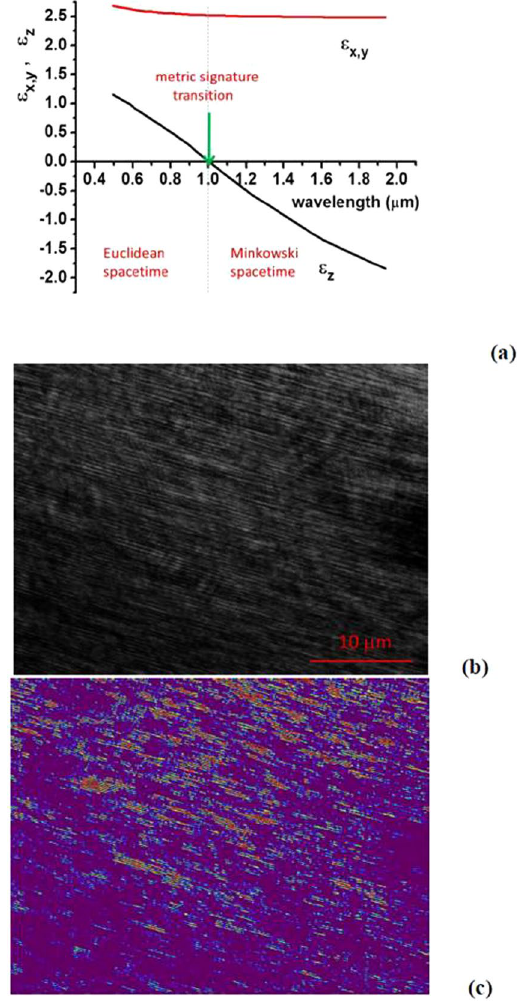
Figure 2. ( a ) Wavelength dependencies of the real parts of ε z = ε 2 and ε x,y = ε 1 for a cobalt nanoparticle-based ferrofluid at α = 8.2% volume fraction of nanoparticles. While ε x and ε y stay positive and almost constant, ε z  changes sign to negative around λ = 1 μ m. ( b ) Microscopic image I r ( ) of cobalt nanoparticle-based ferrofluid in external magnetic field reveals nanoparticle alignment along the field direction. ( c ) Image of the stripe contrast (cid:31)(cid:30) − /2) , where d is the periodicity of stripes visible in ( b ). This numeric procedure emphasizes ferrofluid regions having larger volume fractions of nanoparticles α ( Η , Τ ) aligned into the nanochains. According to Eq. (5), these regions behave as “Minkowski domains” separated by regions of Euclidean spacetime. Note that these experimental images were obtained under non-stationary conditions, while the external magnetic field was varied during the experiment. The time frame for the magnetic field variations was several